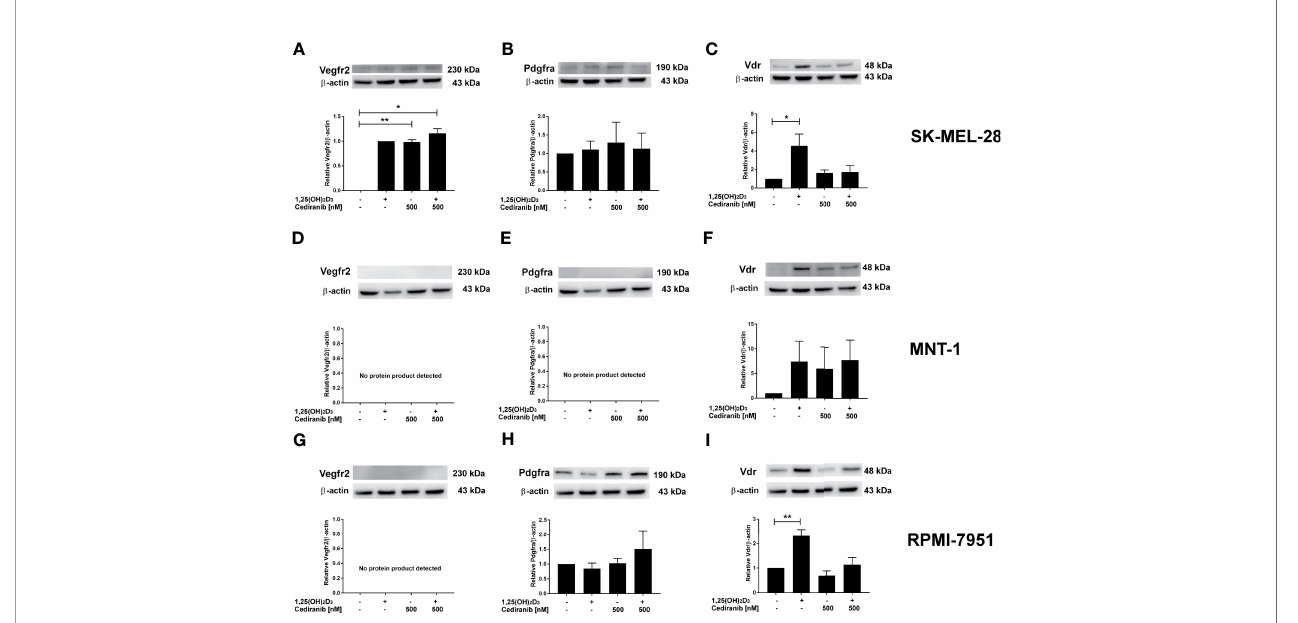
FIGURE 6 | The effect of 24-h preincubation with 1,25(OH) 2 D 3 at 100 nM concentration on VDR (C, F, I) , PDGFRa (B, E, H) , and VEGFR2 (A, D, G) protein level in SK-MEL-28 (A – C) , MNT-1 (D – F) , and RPMI-7951 (G – I) melanoma cells treated subsequently for 24 h with cediranib at 500 nM concentration. Protein levels were measured by Western blotting, with b -actin used as a control. Data are shown as mean from three independent experiments ± SEM. Statistical signi fi cance was estimated using one-way ANOVA followed by Tukey ’ s multiple comparison test and presented as * p < 0.05 and ** p < 0.01 vs. untreated control or between the two groups indicated by the